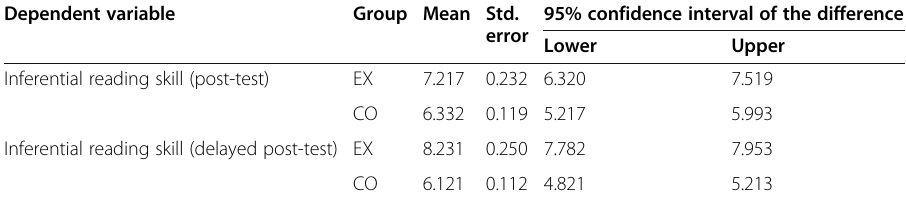
Table 6 Unadjusted mean differences of the post-tests and delayed post-tests for both groups Dependent variable